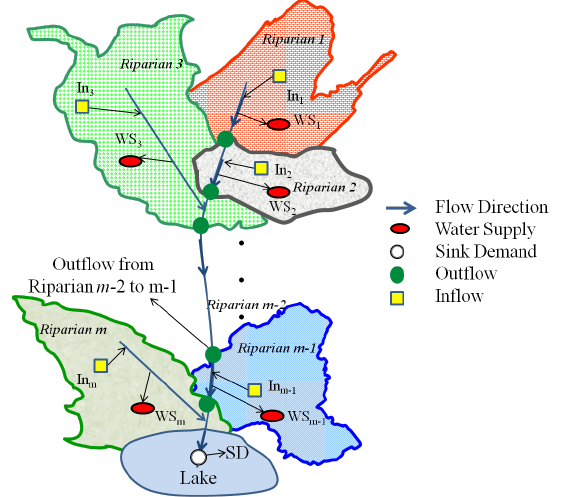
Figure1. Schematic map of a trans-boundary river network Figure 1. Schematic map of a transboundary river network.